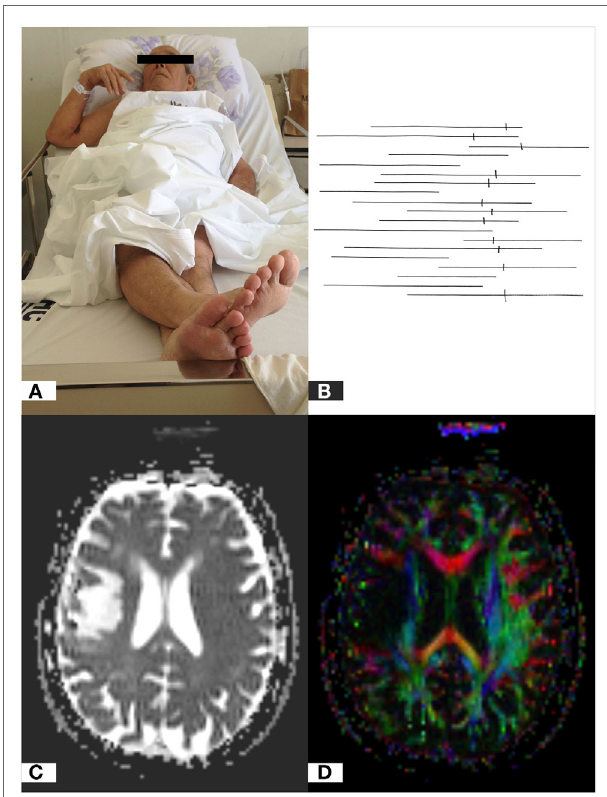
FigUre 2 | Crossed leg sign in a patient with unilateral spatial neglect (a) ; line bisection test showing right deviation of the midline (B) ; axial apparent diffusion coefficient map (c) ; and diffusion tensor imaging tractography (D) showing a lesion in the right frontoparietal region involving cortico-subcortical portions.